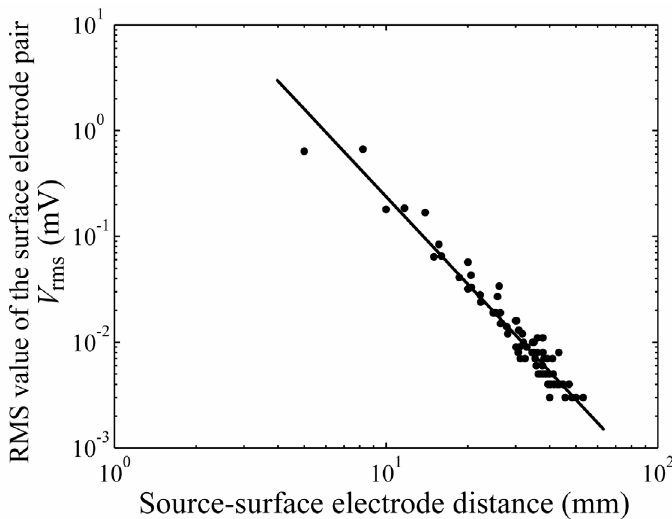
Fig. 4 RMS values of the surface electrode vs. source-surface distance. The dots in the figure represent the RMS values of all surface electrodes and all source depths. (20Hz source frequency, for one of the five